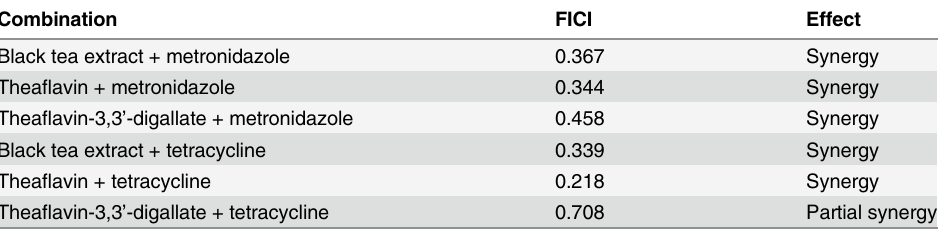
Table 2. FICI values of the effect of the black tea extract, theaflavin, or theaflavin-3,3 ’ -digallate in com- bination with metronidazole or tetracycline on P . gingivalis ATCC